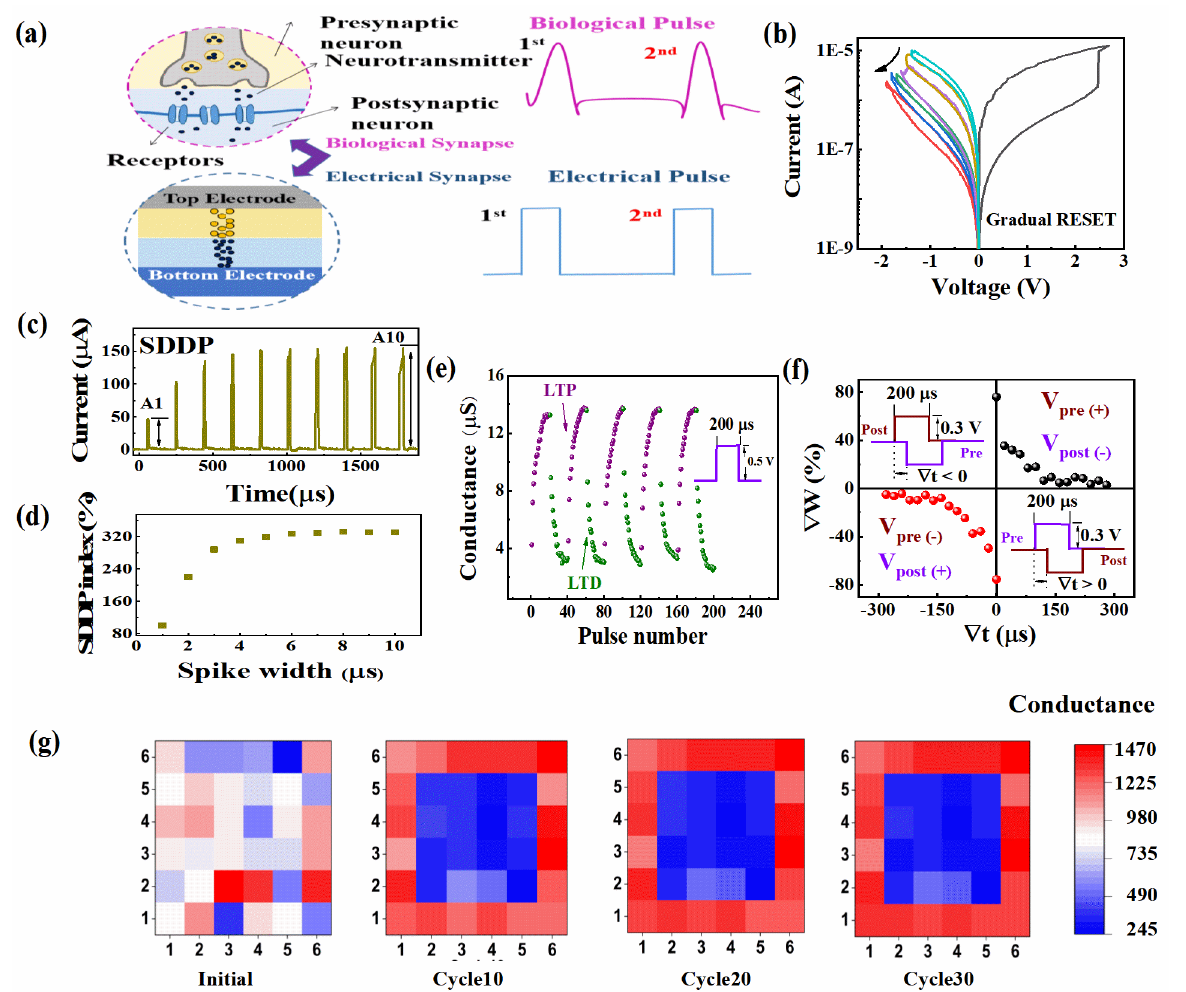
Figure 6. ( a ) A schematic diagram of biological synapse and electrical synapse; ( b ) Multilevel resistive switching characteristics of the Al/TiSbTe/a-SiC 0.11 :H/P + -Si device, with different reset stop voltage; ( c ) The SDDP characteristics of the Al/TiSbTe/a-SiC 0.11 :H/P + -Si device; ( d ) The SDDP index (An/A1 · 100%; n = 1, 2, 3, . . . , 10) of the Al/TiSbTe/a-SiC 0.11 :H/P + -Si device; ( e ) Incremental conductance changes through 20 positive pulses (0.5V, 200 µ s) followed by 20 negative pulses ( − 0.5 V, 200 µ s); ( f ) Spike-timing-dependent plasticity (STDP) of the Al/TiSbTe/a-SiC 0.11 :H/P + -Si device through the overlapping of the pre-synaptic spike and the post-synaptic spike; ( g ) The simulation of image memorization under consecutive electrical pulses.